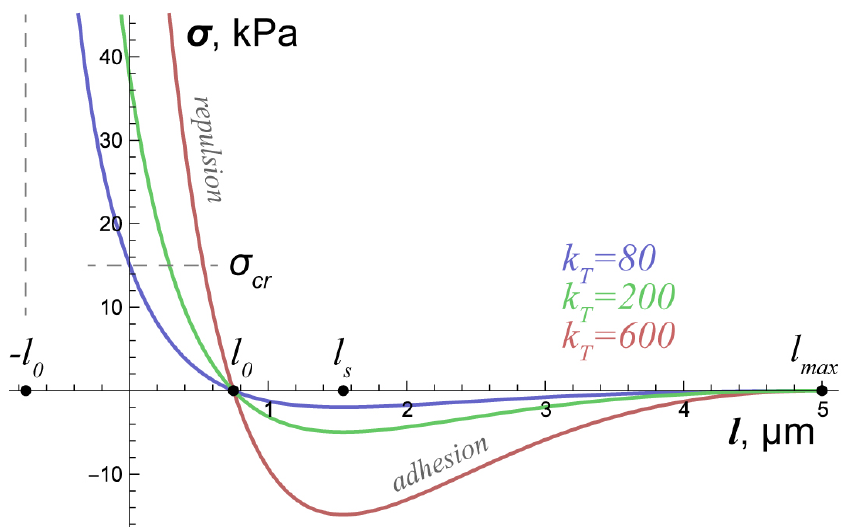
Figure 1. Dependence of solid stress σ on the length of the bonds between cells l , expressed in Equation (1), for designated values of k T . The parameter values are based on the basic parameter set, which is listed in Table 1, where l s is the bond length at which cell attraction is the strongest for any value of k T